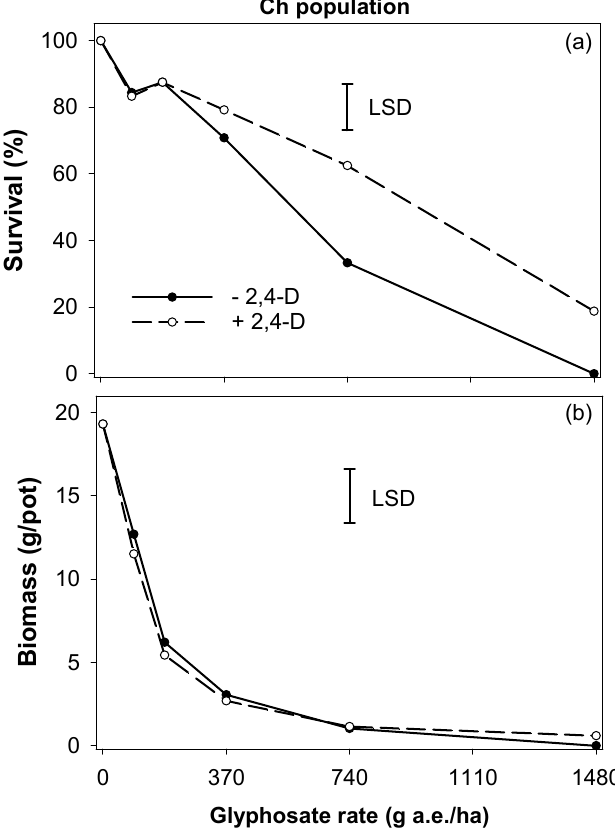
Figure 3. The antagonistic effect of 2,4-D on glyphosate efficacy for the Ch population of Chloris virgata in terms of ( a ) survival (%) and ( b ) biomass (g pot − 1 ); LSD: least significant difference at the 5% level.